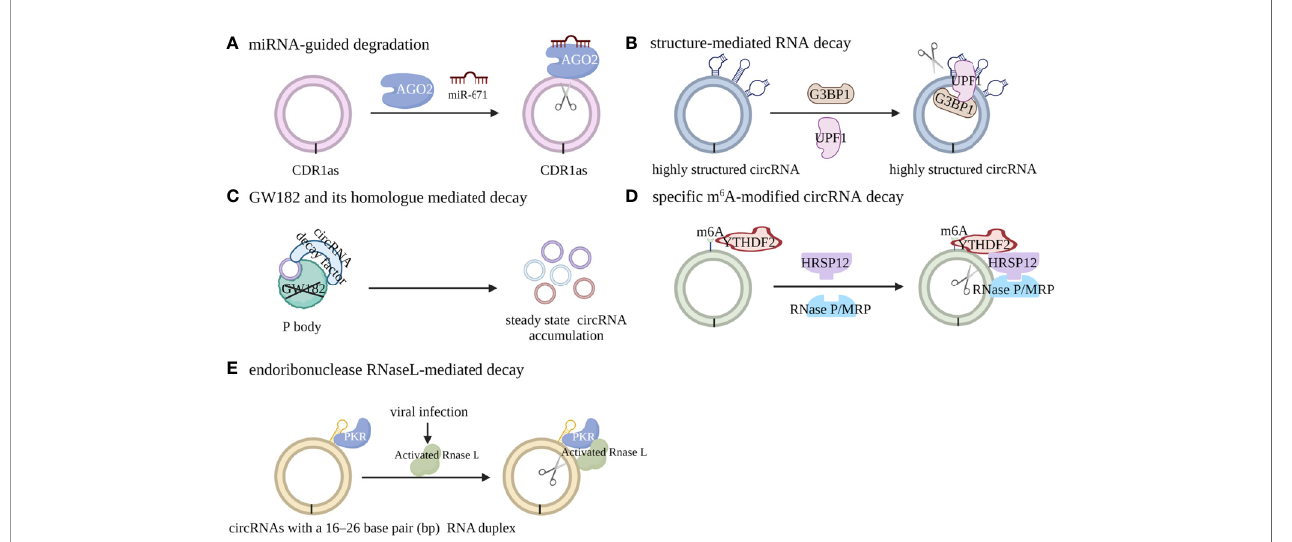
FIGURE 2 | Mechanisms of circRNA degradation. (A) CircRNA CDR1 can be cleaved by endonuclease AGO2 with the assistance of miR-671 in a miRNA target sequence-dependent manner. (B) The degradation of highly structured circRNAs can be regulated by UPF1 and G3BP1, both of which recognize and unwind the overall structures of circRNAs. (C) m 6 A-modi fi ed circRNA can recruit the m 6 A reader protein YTHDF2 as well as the adaptor protein HRSP12, and HRSP12 can serve as a bridge to connect YTHDF2 with the endoribonuclease RNase P/MRP, thus enabling degradation of m 6 A modi fi ed circRNA by RNase P/MRP. (D) The absence of GW182 or its human homologue TRNC6A/B/C, the key component of P body and RNAi complexes, can lead to the accumulation of endogenous circRNA and increase the steady state of cytoplasmic circRNAs. (E) Upon viral infection, RNase L can be activated and can degrade circRNAs with RNA duplexes containing 16 to 26 bp through an unde fi ned